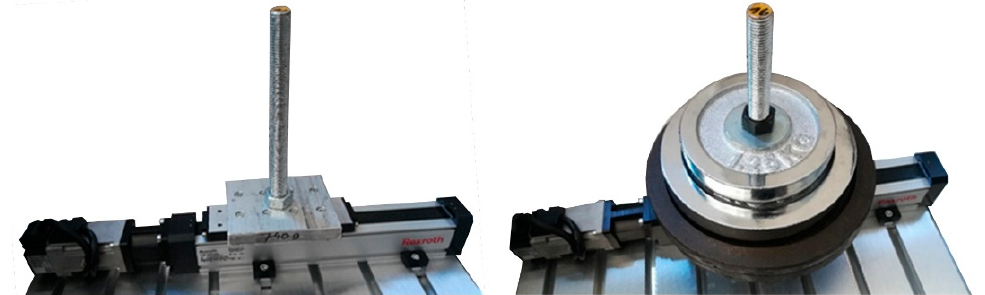
Figure 9. Experimental set-up—axle with holder for dumbbell weights and without additional mass (on the left side); axle with additional mass of 9.5 kg (on the right side).